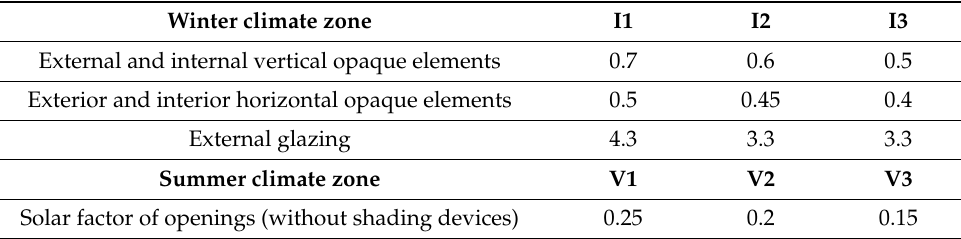
Table 9. Thermal transmittance (W/m 2 K) and solar factor of openings [28].